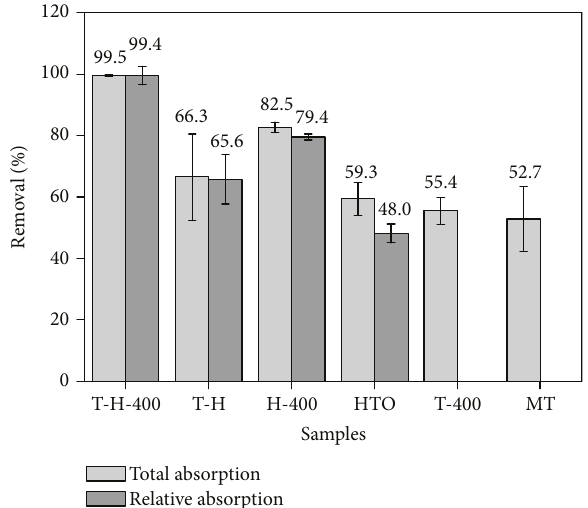
Figure 10: Photodegradation rate of 2,4-DCP solution for 1h by all materials. Total absorption is in accordance with equation (1). Relative absorption is in accordance with equation (2).